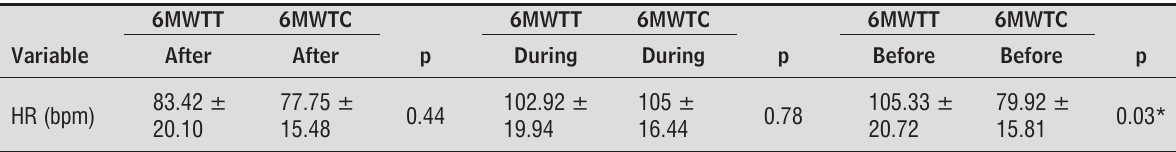
Table 2 - Mean and standard deviation of heart rate (HR) in 24 cardiac patients submitted to the six minute walking test in the treadmill (6MWTT) and in the corridor